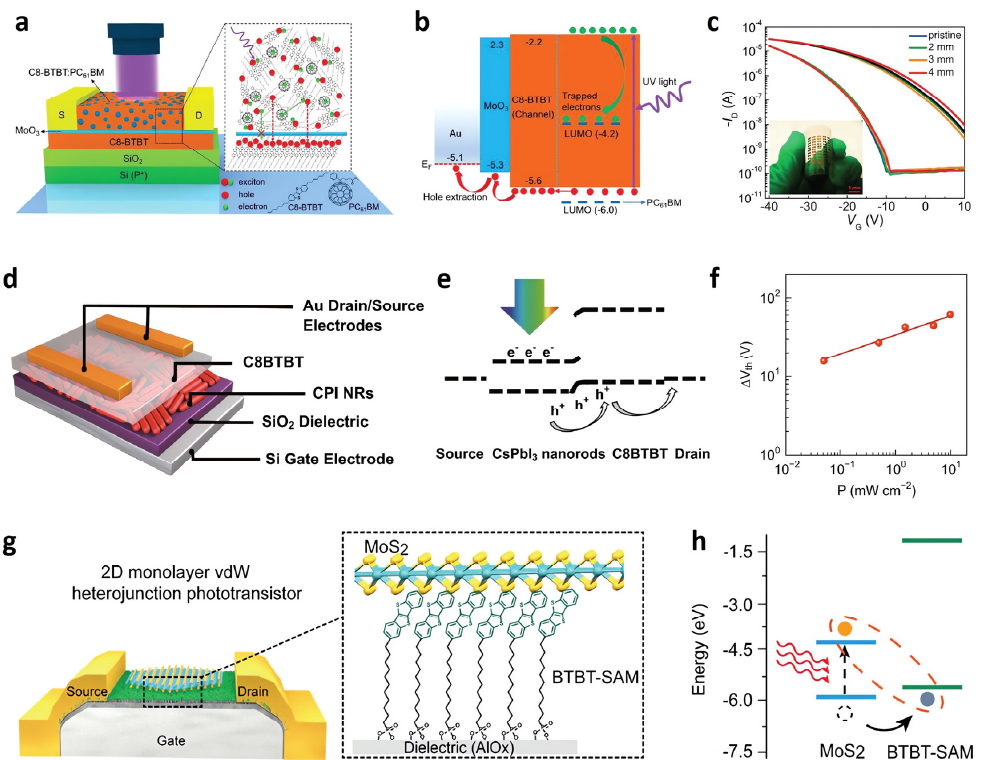
Figure 5. Organic-based photodetector. ( a ) Schematic illustration of the HL-OPT. ( b ) Energy band diagram of the HL-OPT device under UV illumination. ( c ) Transfer characteristics of the flexible HL-OPT with various bending radii with and without UV light. ( d ) Schematic illustration of the C8BTBT/CsPbI 3 nanorod-based phototransistor. ( e ) Schematic diagram of a photogenerated carrier flow in the hybrid phototransistor under light irradiation. ( f ) V Th shift of the hybrid phototransistor as a function of light intensity. ( g ) Scheme of the 1L-MoS 2 /BTBT-SAM heterostructure device. ( h ) Energy band diagram of the 1L-MoS 2 and BTBT-SAM under light irradiation. ( a – c ) Reproduced with permission from [16]. Copyright Wiley, 2019. ( d – f ) Reproduced with permission from